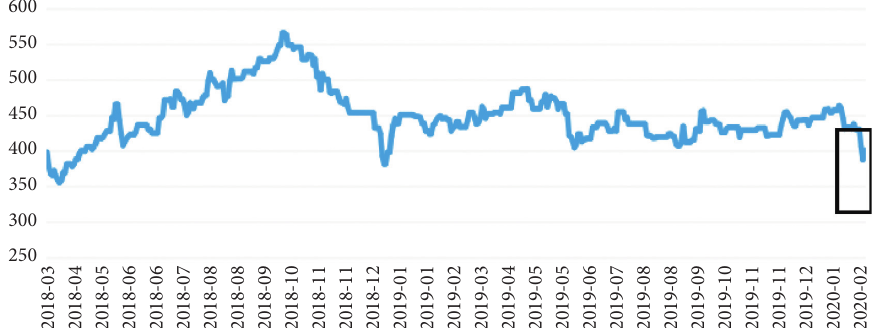
Figure 11: Shanghai crude oil futures real price trend